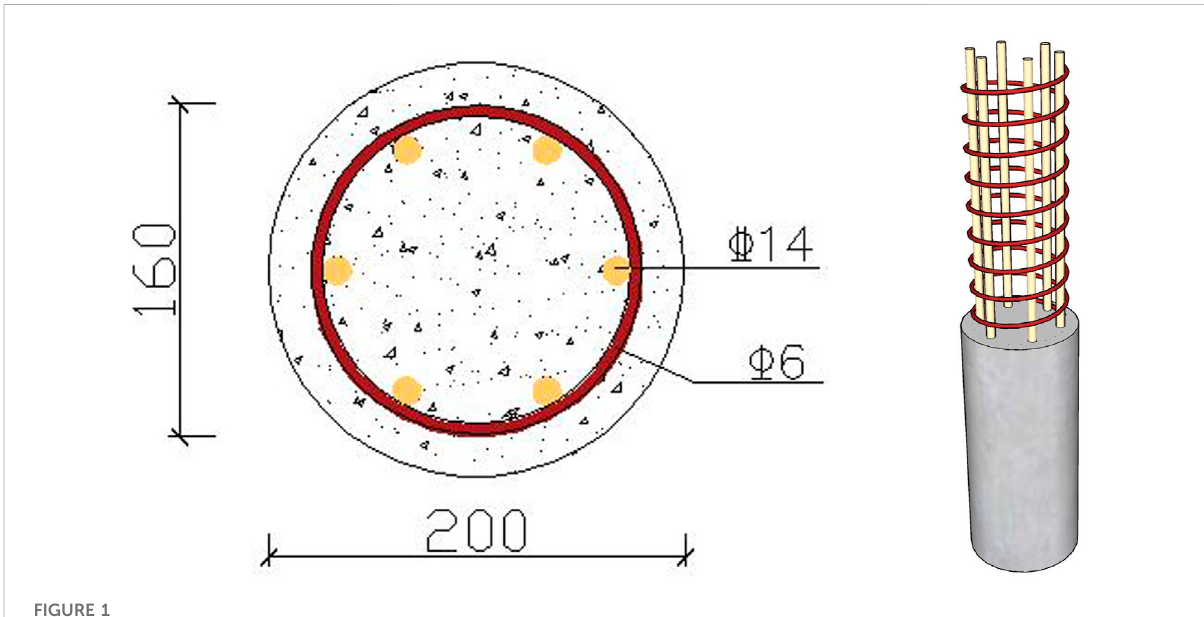
FIGURE 1 Cross-sectional dimensions and